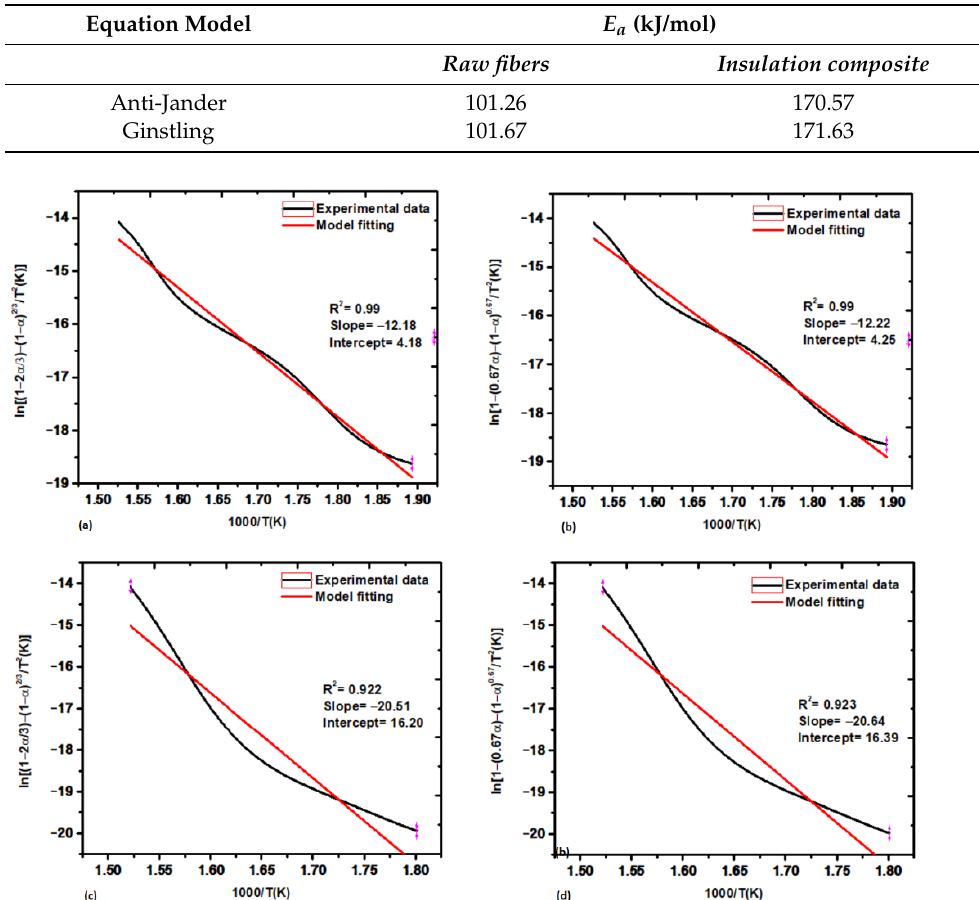
Table 6. Activation energy ( E a ) of date palm fibers and the insulation composite.